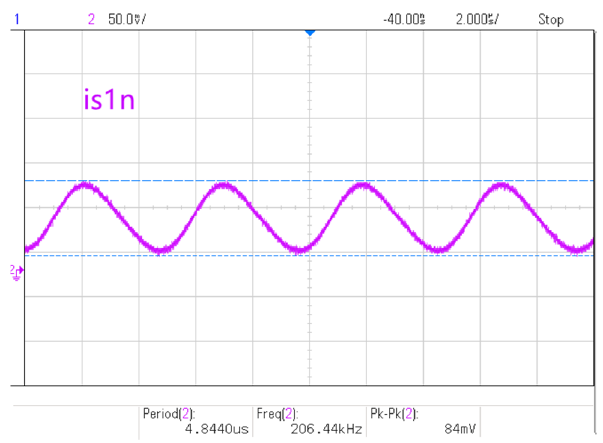
Figure 24. IDC static input current waveform .